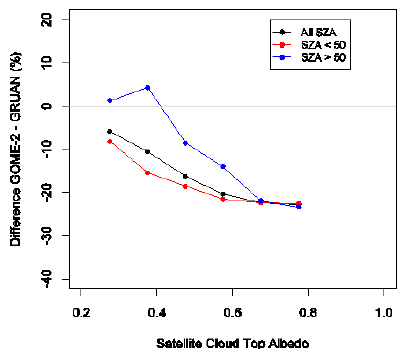
Figure 7. Differences between TWVC data retrieved by GOME-2 and GRUAN sounding data (Eq. 3) as function of satellite cloud pressure for all cloudy cases (CF > 50%), and those cloudy cases with satellite SZA < 50 ◦ , and SZA > 50 ◦